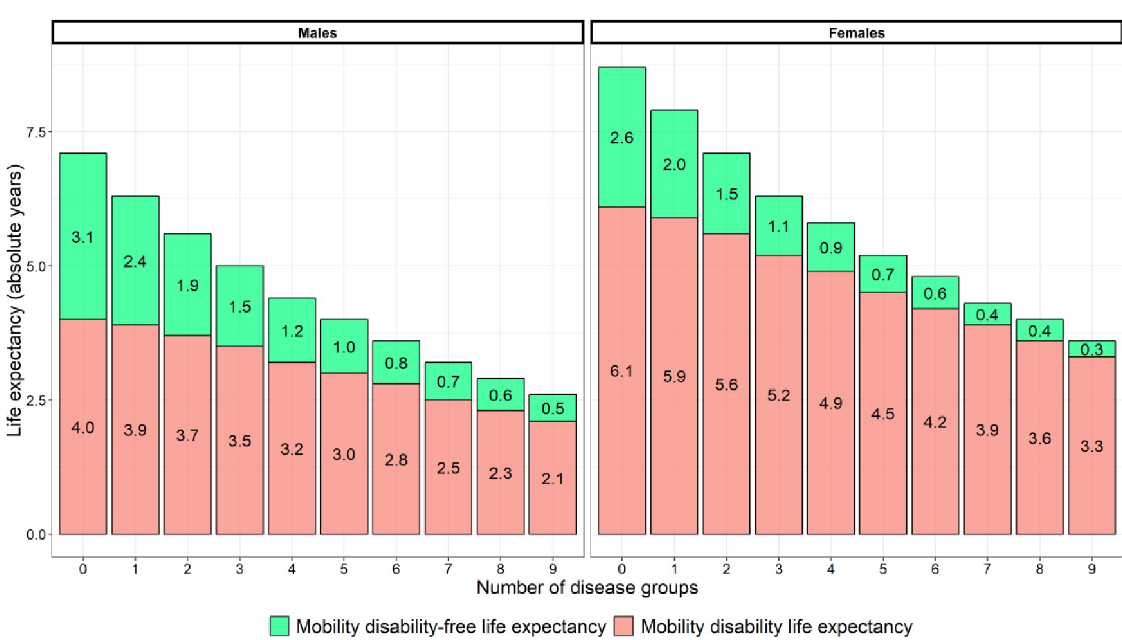
Fig 3. Remaining life expectancy (in years) spent with and without mobility disability for each disease group count, in male and female participants at age 85.